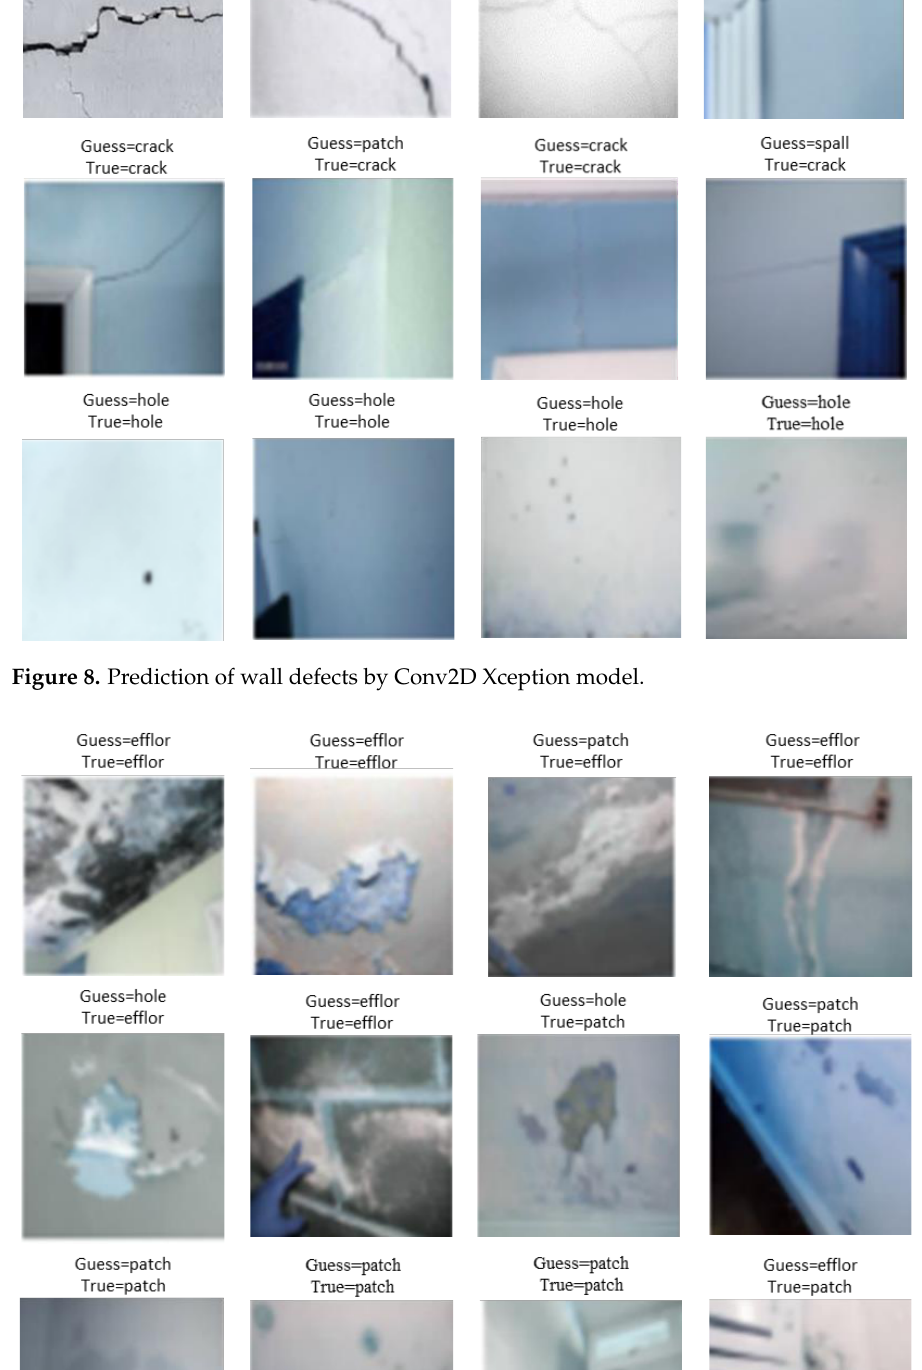
( d ) Figure 7. Model loss and accuracy of Conv2D models during cross validation. ( a ) Model accuracy of DenseNet; ( b ) nodel loss of DenseNet; ( c ) model accuracy of ResNet; ( d ) model loss of ResNet. The wall quality dataset was fitted with the Conv2D ResNet model, which acted as a base model, thereby learning the types of wall defects from 90% of the training data. Now the model had learnt the exact region of interest through which it categorized the wall defect class as cracks, holes, efflorescence, damp patches, or spalls from the more signifi- cant number of images. The acquired knowledge from Conv2D ResNet was transferred